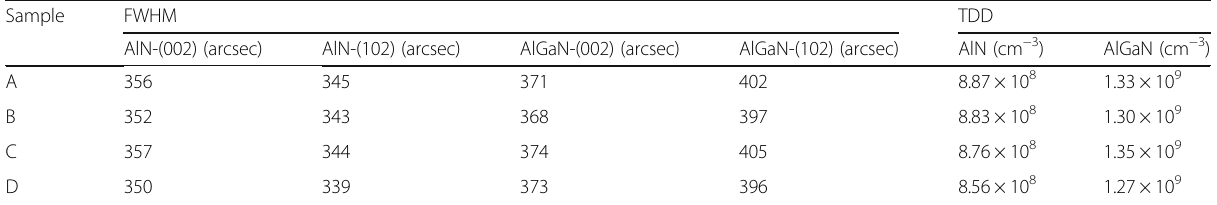
Table 1 Crystalline quality characterization of AlN and n-type AlGaN layers of samples A, B, C, and D by high-resolution X-ray diffraction along symmetric (002) plane and asymmetric (102) plane. Threading dislocation density (TDD) was calculated according to ref.